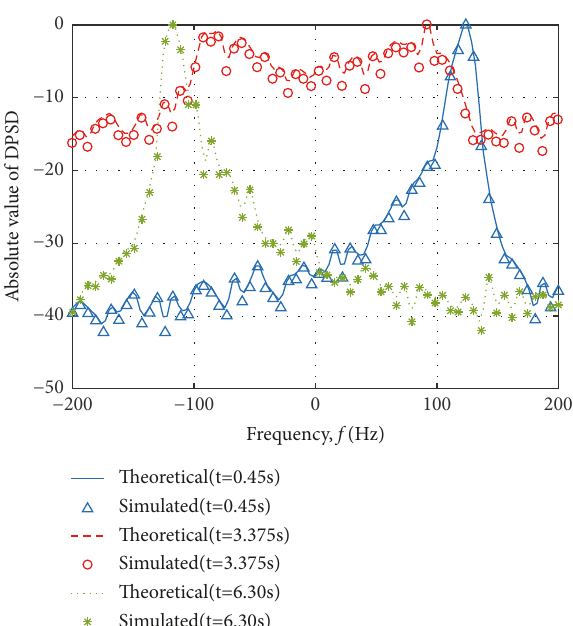
Figure 7: Three typical Rx locations with respect to Tx.